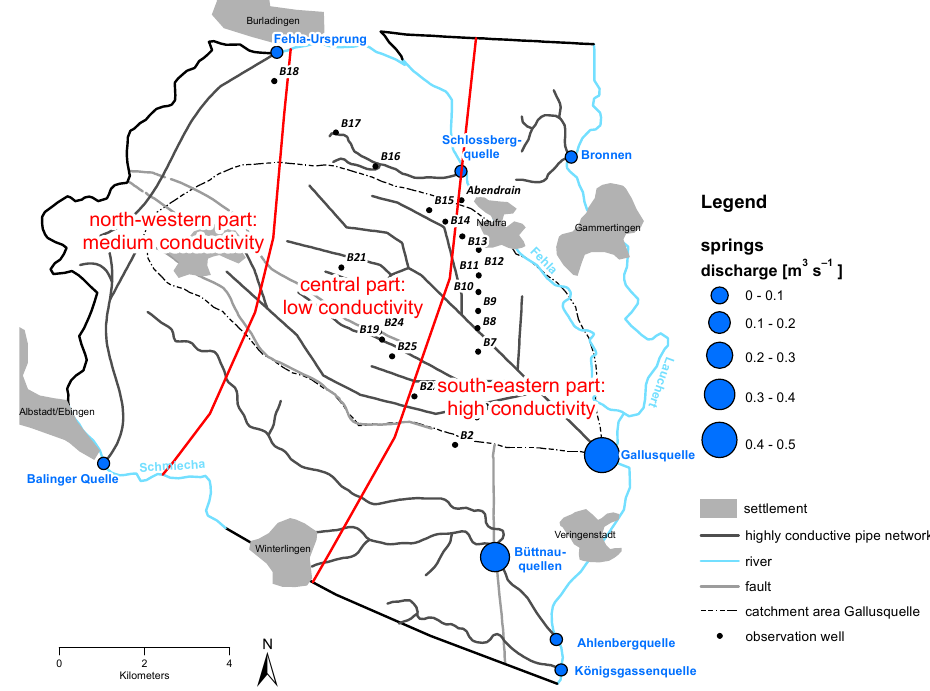
Figure 9. Model catchment with spatially distributed hydraulic conductivities. The model area is divided into three parts after geologic aspects. For each segment different values of the hydraulic conductivity were examined during parameter analysis in scenario